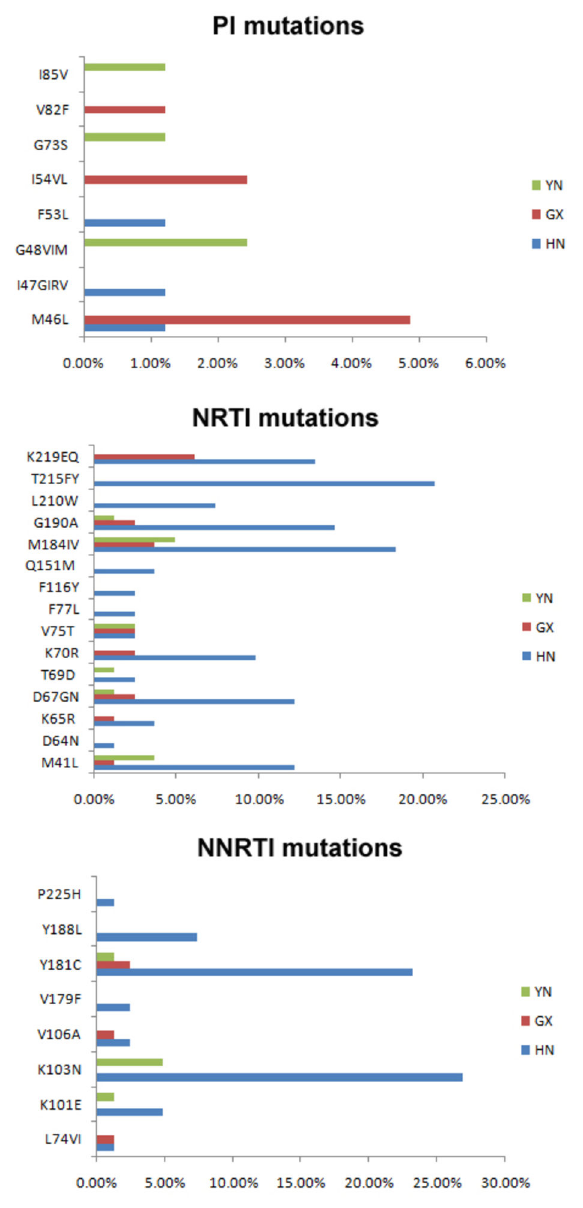
HIV infected individuals residing in Henan, Guangxi and Yunnan. Mutations presented in strains from Henan, Guangxi and Yunnan were marked separately in blue, red and green. doi: